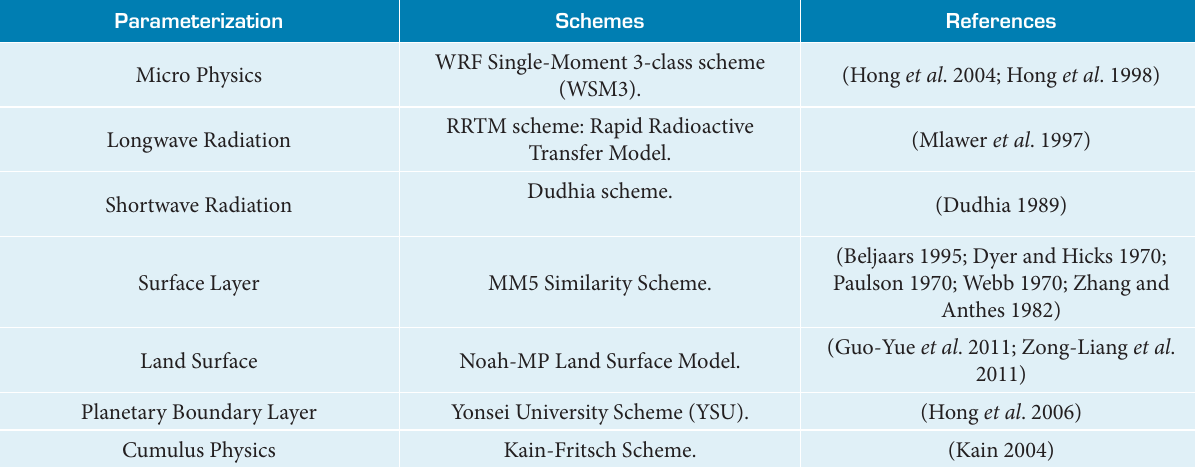
Figure 2. Domains of the model grids. The points marked on the map refer to the automatic weather stations used for the model performance evaluation, corresponding to: “A”, Belém; “B”, Castanhal; “C”, Capitão Poço; and “D”, Soure. Table 1. Parameterizations used in the numerical